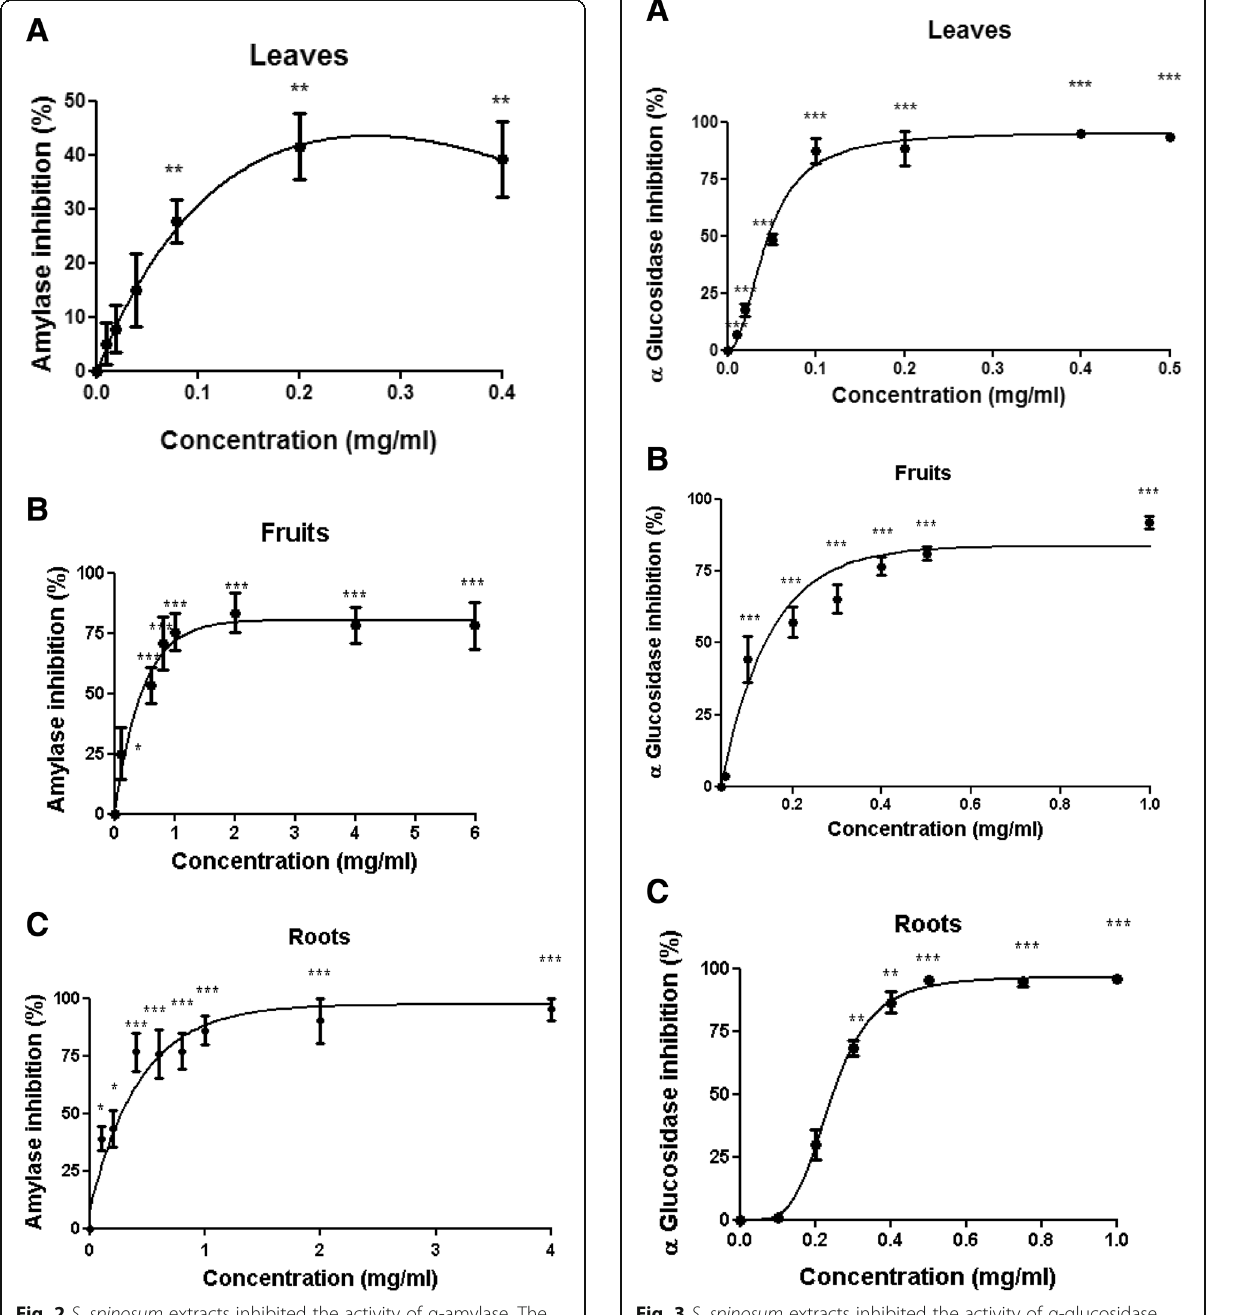
Fig. 2 S. spinosum extracts inhibited the activity of α -amylase. The activity of α -amylase in the presence or absence of leaves ( a ), fruits b or roots c extracts was measured as described in Materials and Methods . Results are mean ± SEM of % inhibition of 5 independent experiments. * p < 0.05, ** p < 0.005, *** p < 0.0005 compared to untreated cells by Student ’ s t -test